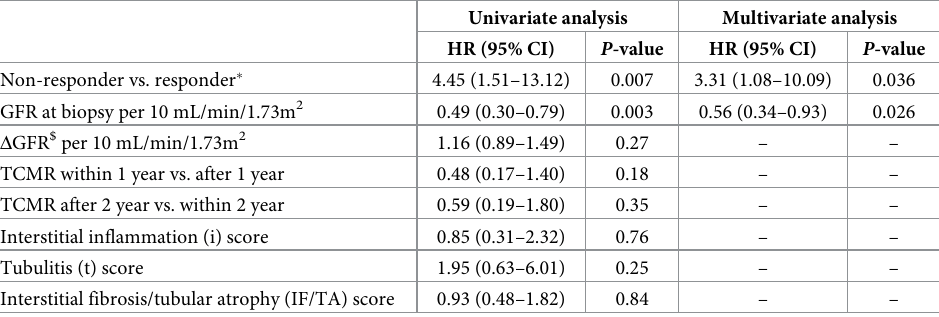
Table 5. Risk factors associated with graft failure.